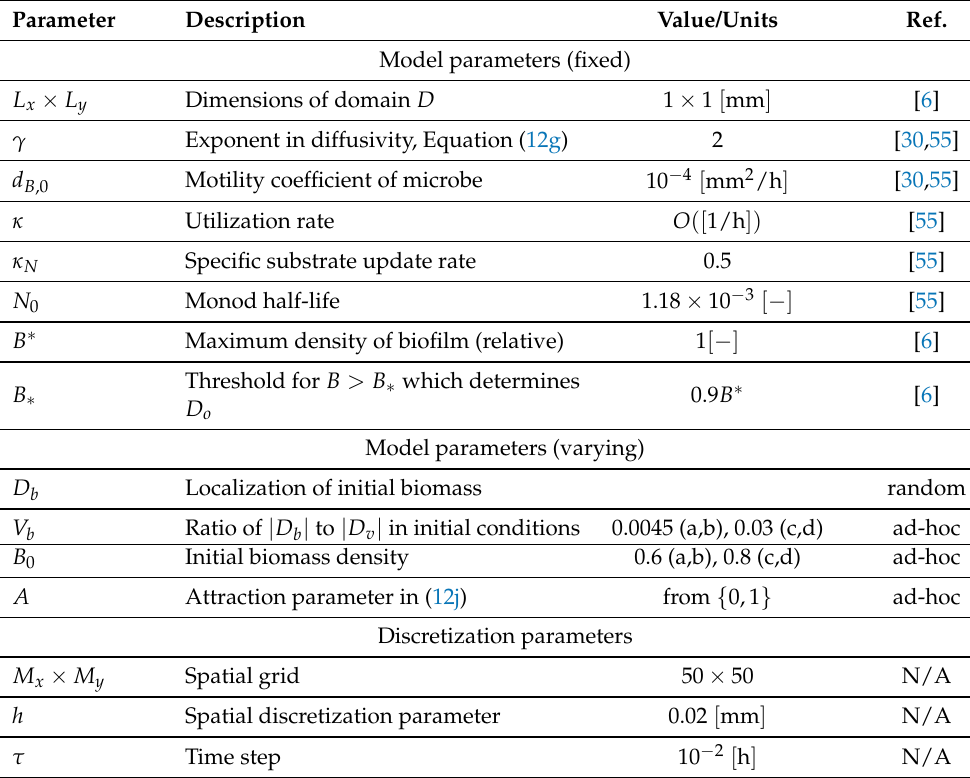
Table 2. Parameters for the DNS model and simulations of ( B , N ) described in Section 3.1. Simula- tions cases (a,b,c,d) are